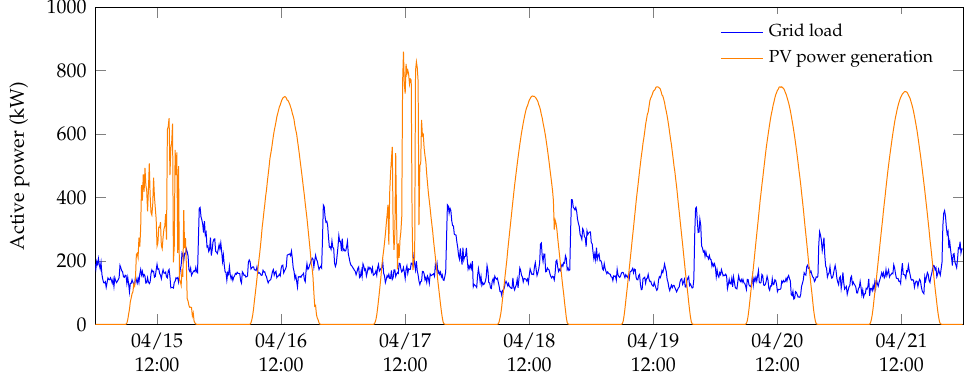
Figure 1. Grid load and PV power generation over a week in April (case